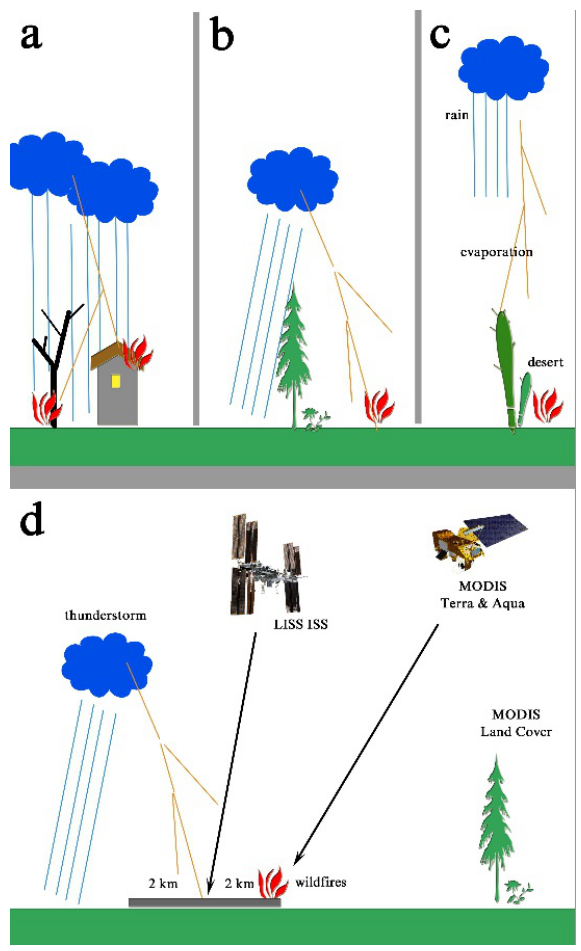
Figure 1. The schemes of the main lightning wildfire types are as follows: ( a ) wet lightning wildfire of objects which contain loose, dry materials, such as a dead tree, haystack, or house; ( b ) edge lightning or sloping lightning wildfire; ( c ) a dry thunderstorm wildfire that mainly takes place over hot deserts. The investigation scheme is additionally presented in ( d ).